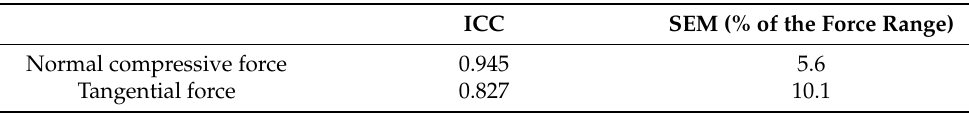
Table 6. The correspondence between the reaction force on the tibial plateau as measured directly [26], and as estimated using SGM. Figure 5. Vastus medialis muscle force for the third subject with a 6 kg payload. Gray markers correspond to the force estimated by the model and those in black are for estimated muscle force based on Force–EMG calibration curves using payloads of 0 kg and 12 kg.